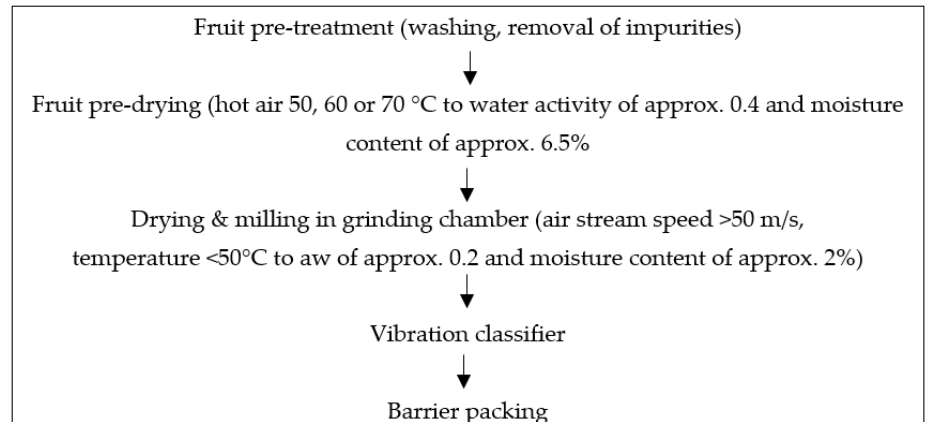
Figure 1. Schematic representation for preparing powders using the FBJD (fluidized-bed jet milling and drying) method.